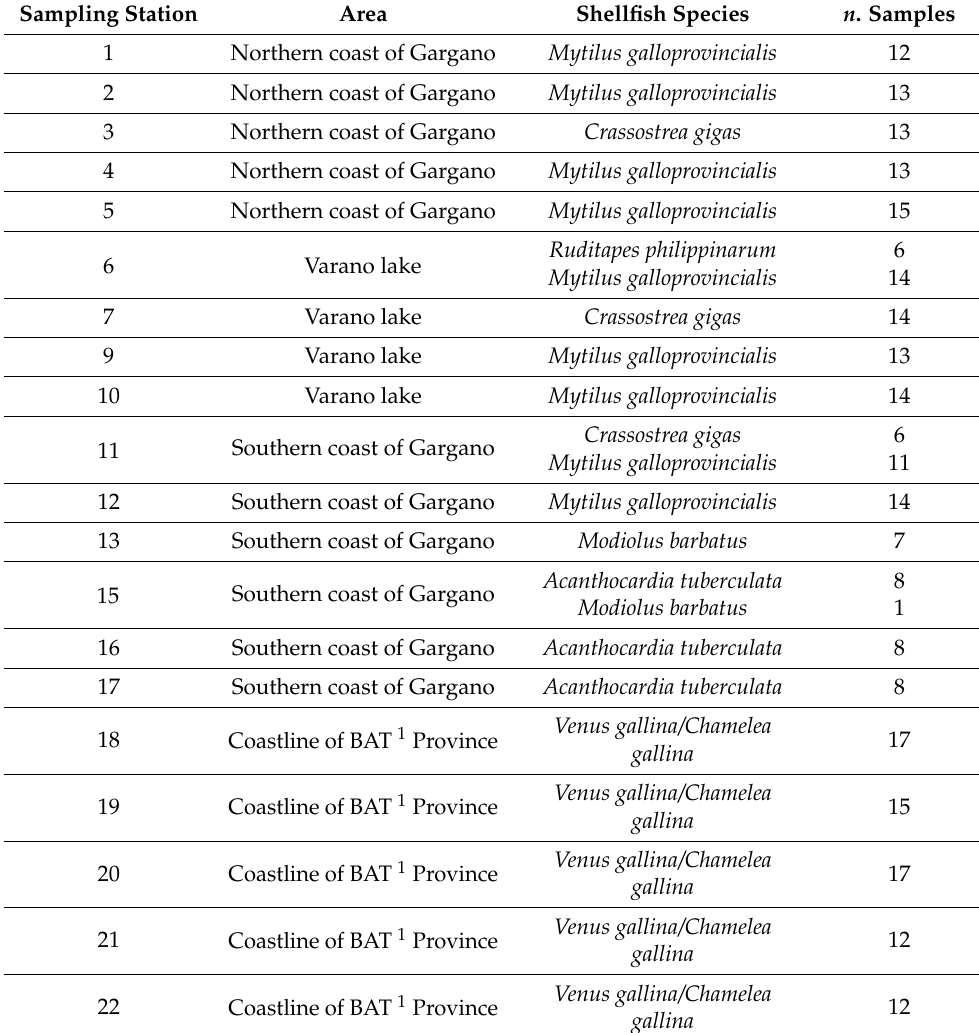
Table 1. Number and type of samples for each sampling